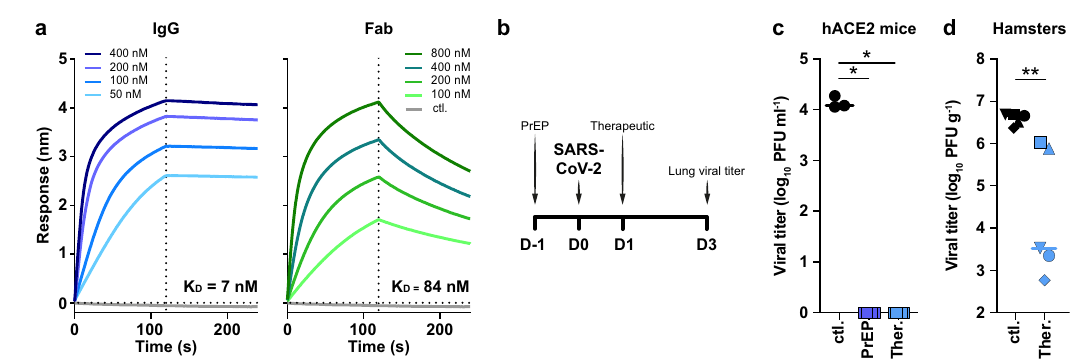
Fig. 1 COVA1-18 avidity and SARS-CoV-2 protection in rodents. a Biolayer interferometry sensorgrams comparing COVA1-18 IgG and Fab binding to RBD. K D s are indicated. Representative of 3 independent experiments. b Study design with n = 5 per group, except mouse control group ( n = 3). Hamsters were infected with 10 5 PFU on day 0 and treated on day 1. Mice received COVA1-18 24 h prior to or after exposure to 10 4 PFU. Lung viral titers at 3 days post-infection are shown for mice ( c ) and hamsters ( d ). Bars indicate medians. Mann-Whitney unpaired two-tailed t-test, p values: *:0.0179, **:0.0079. Ctl. control group (black), KD dissociation constant, PFU Plaque forming unit, PrEP pre-exposure prophylaxis (dark blue), Ther. therapeutic (light blue).